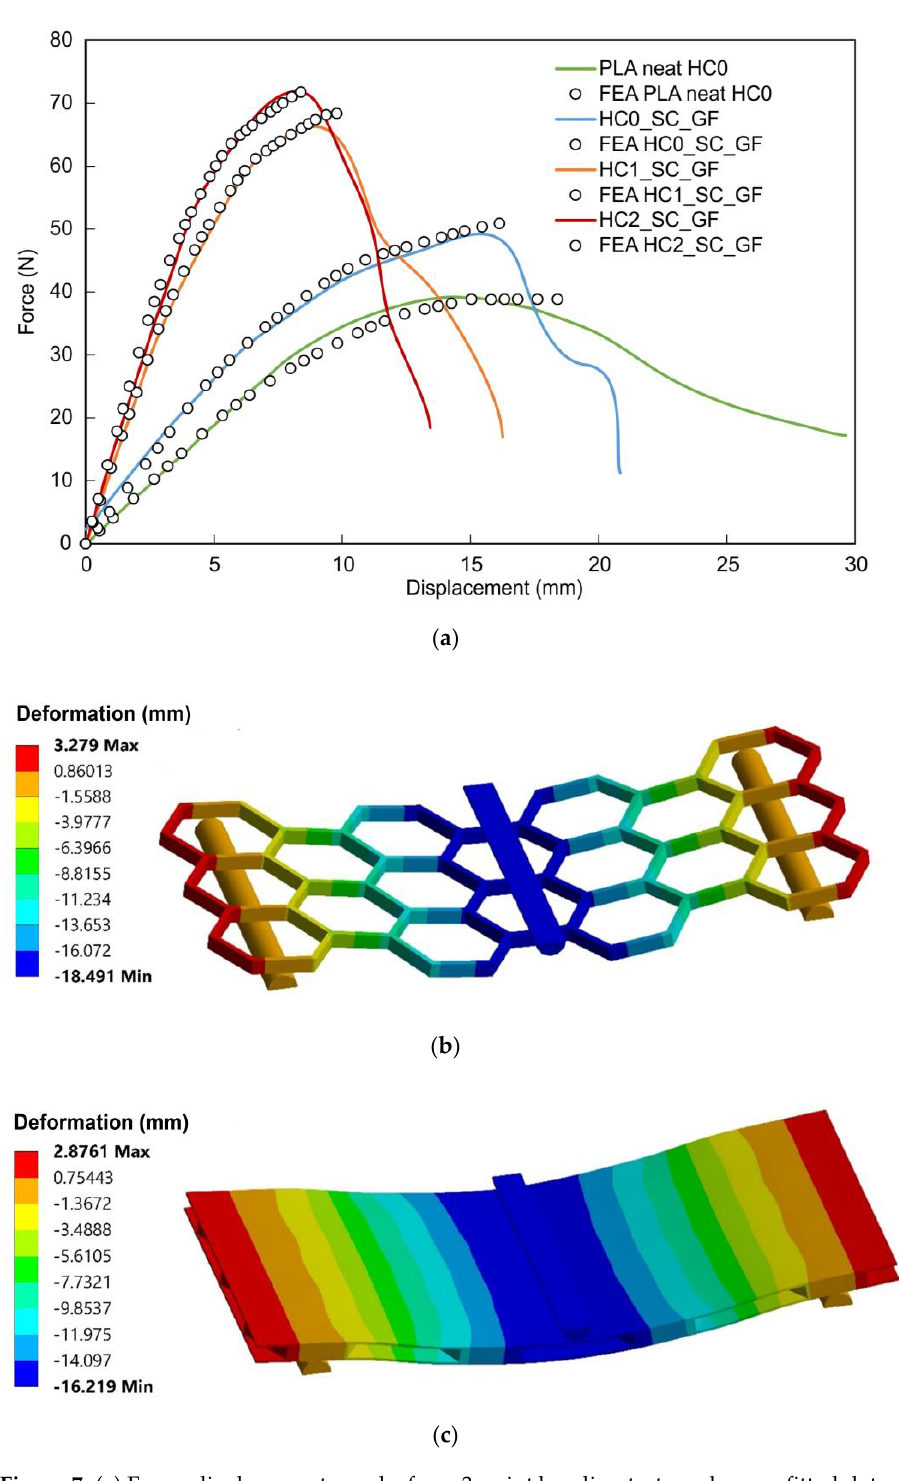
Figure 7. ( a ) Force–displacement graphs from 3-point bending tests and curve-fitted data obtained from the FEA, ( b ) the deformation behavior of the PLA specimens and ( c ) the deformation behavior of PLA HC0 sandwich specimens.